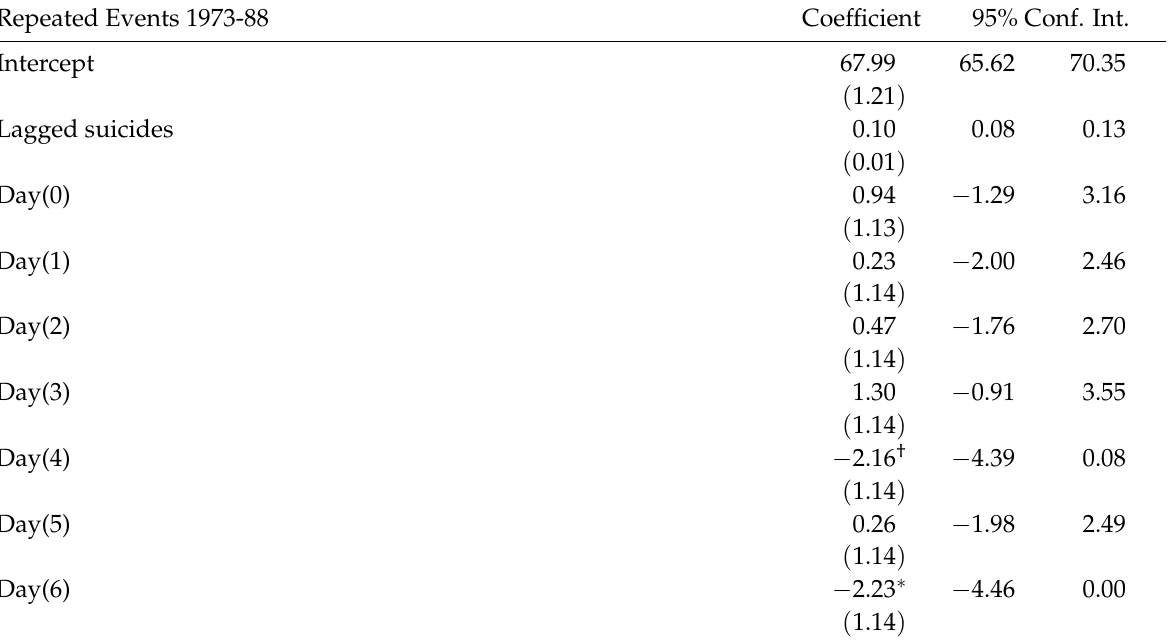
Table 7: The attenuating effect of repeated (constructive) events on suicide mortality Repeated Events